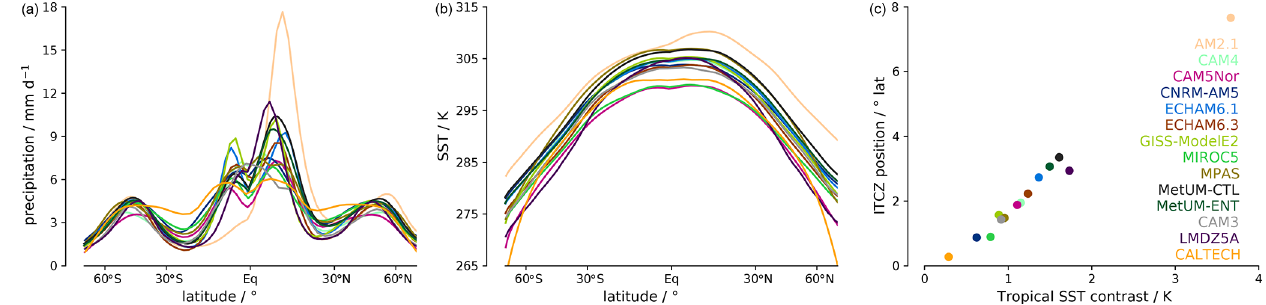
Figure 1. Time average zonal-mean precipitation (a) and surface temperature (b) in the AquaControl simulations. (c) The tight correlation of the time average ITCZ with the SST contrast between the Northern and Southern Hemisphere tropics.